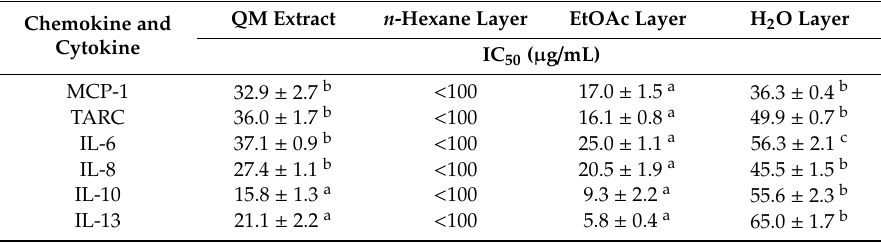
Table 1. Inhibition of chemokine and cytokine production by QM extracts and fractions.